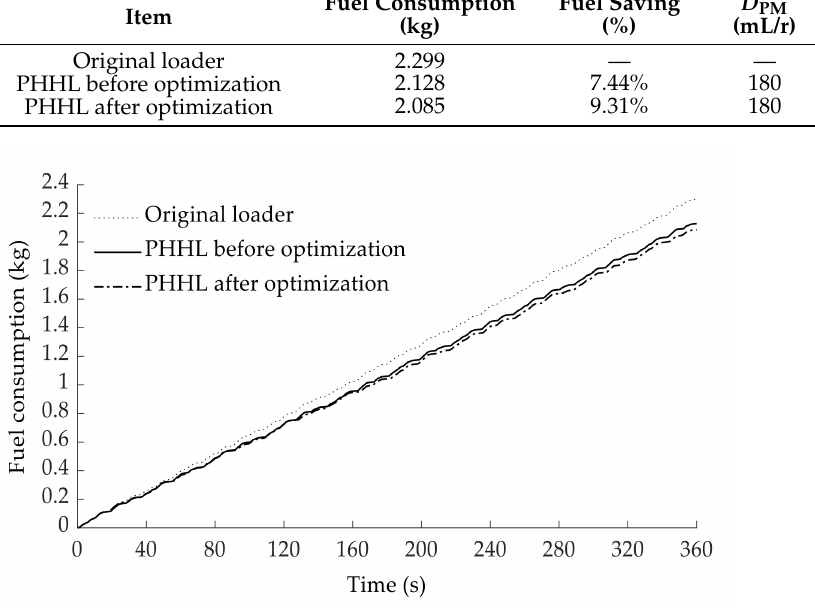
Figure 18. Fuel consumption of the original loader and PHHL.